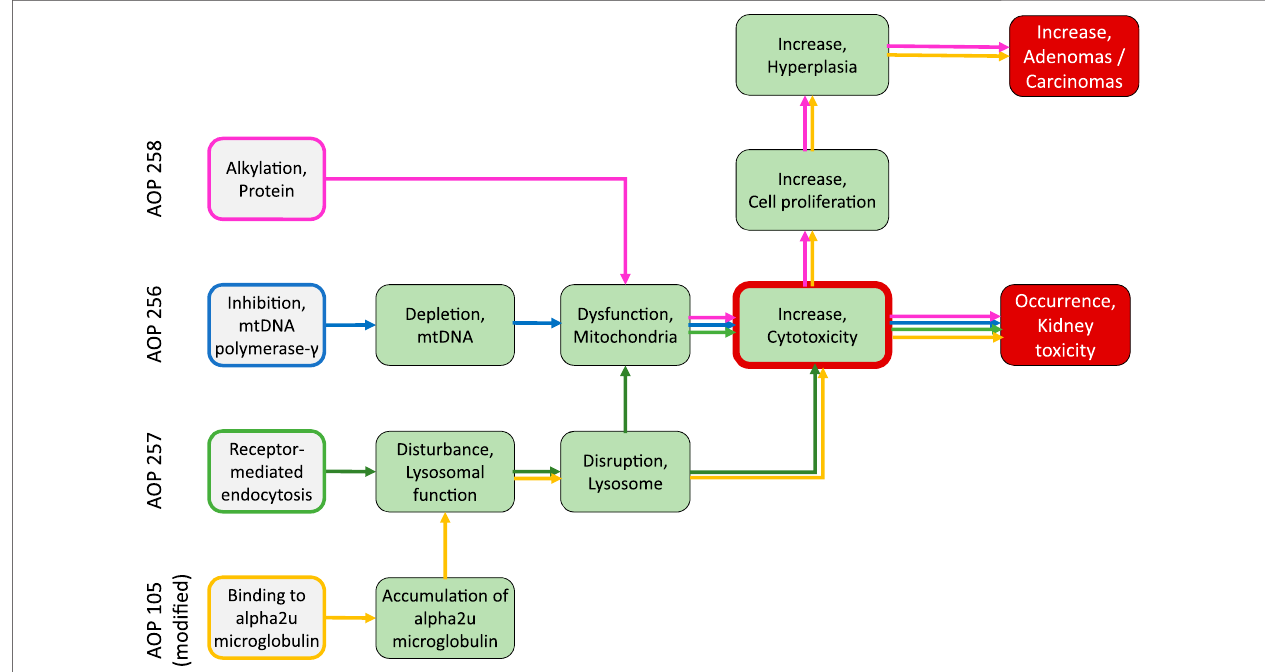
FIGURE8| Aninitial networkofAOPsleadingtokidney toxicity, withmitochondrial dysfunction and renaltubular cellcytotoxicityascommon KEs.Sustainedrenal tubularcellcytotoxicityisalsorecognizedasanimportanttriggerforregenerativecellproliferation,resultinginhyperplasiaandultimatelyrenaltumors.Whilethishasbeen proposed as an AOP in itself with cytotoxicity irrespective of the primary insult as the MIE, this AOP can be initiated by chemicals that bind to alpha 2u macroglobulin in serum in male rats (leading to accumulation of alpha 2u macroglobulin in lysosomes of renal tubular cells, associated with disturbance of lysosomal function and ultimately disruption of lysosomes) but also by chemicals that cause sustained cytotoxicity through protein alkylation. The AOP “ Alpha 2u -microglobulin cytotoxicity leading to renal tubular adenomas and carcinomas (in male rat) ” developed by Charles Wood (US EPA) and published in AOPWiki (https://aopwiki.org/aops/105) was slightly extended to highlight overlapping KEs between alpha 2u nephropathy and the AOP of receptor-mediated endocytosis leading to kidney toxicity. The colored arrows indicate the pathways that lead from a speci fi c MIE through shared KEs to the respective AO in kidney.While cytotoxicity is central KE in all presented AOPs, itis the extent ofcytotoxicity over time that is expected todetermine the AO. Note that - with the exemption of “ Binding to alpha 2u macroglobulin ” which occurs in serum – all MIEs and KEs shown relate to renal tubule cells or renal tubules.